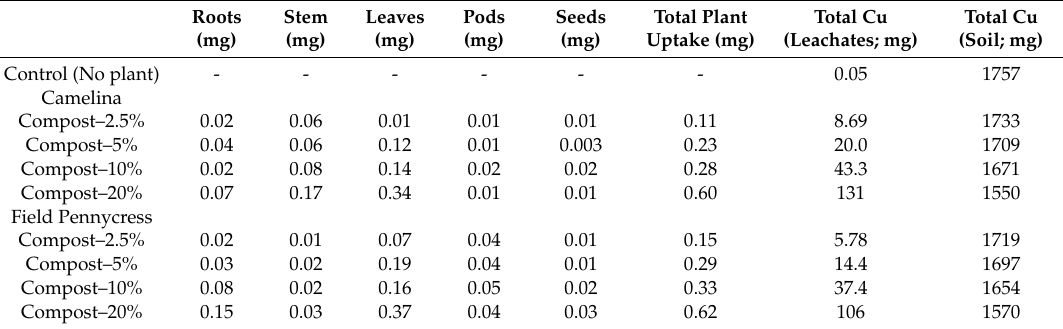
Table 3. Mass balance of Cu for the greenhouse column